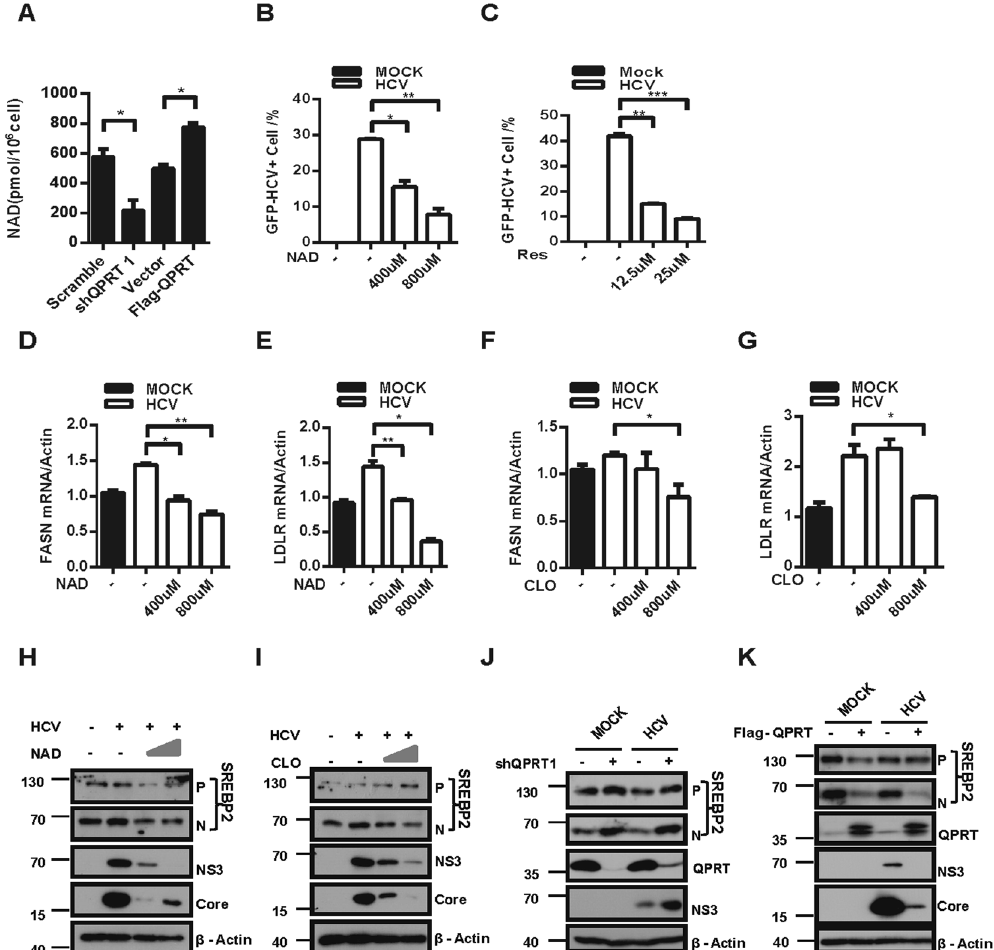
Figure 4. QPRT inhibited HCV replication through modulation of NAD-dependent lipogenesis. ( A ) The intracellular NAD levels were colorimetrically measured in shQPRT cells and Flag-QPRT overexpressing cells. Huh7.5.1 cells were infected with HCV for 6 h, followed by treatments of NAD ( B, D–E,H ), Res ( C ) or CLO ( F,G,I ) for 48 h at indicated doses. HCV replication was measured by FACS ( B,C ), mRNA levels of FASN ( D,F ) and LDLR ( E,G ) were measured by real-time PCR. ( H,I ) Precursor ( P ) and active nuclear forms ( N ) of SREBP2, NS3, Core and β -actin loading control were detected by immunoblotting. ( J,K ) shQPRT cells or Flag-QPRT cells were infected with HCV for 48 h. SREBP2, NS3, Core, QPRT and β -actin loading control were detected by immunoblotting. Full-length gels and blots are included in the Figure S9. Error bars were SEM of three independent experiments. Student t test, * P < 0.05; ** P < 0.01, *** P <